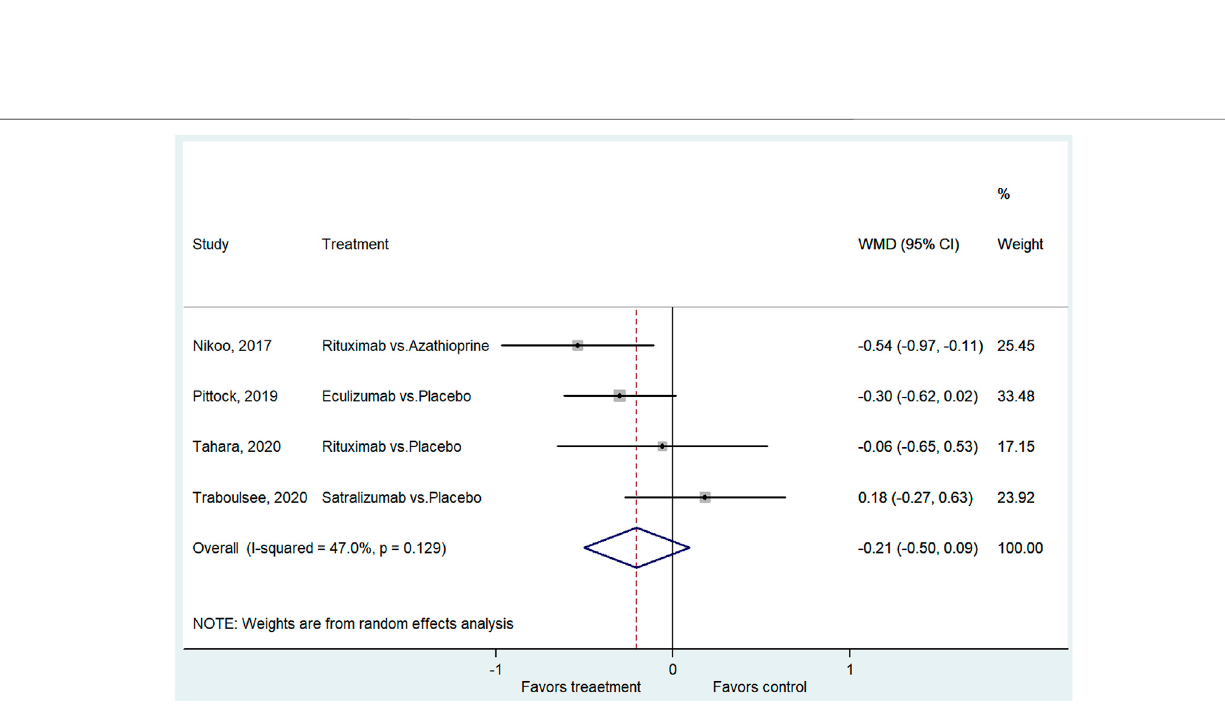
Frontiers in Pharmacology |